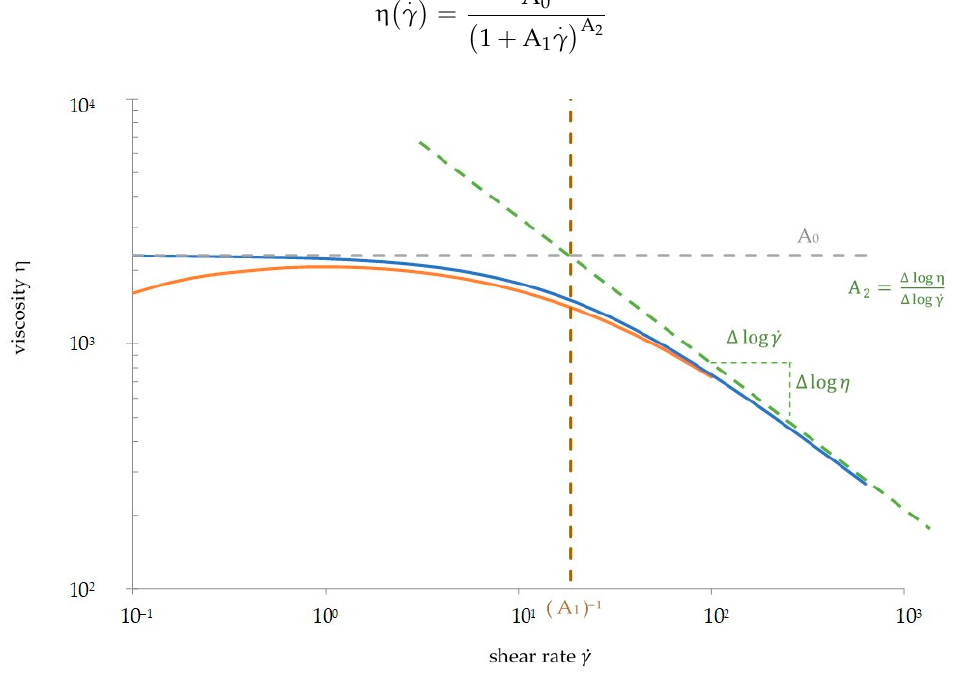
Figure 1. Viscosity curve of thermoplastics. The blue curve is an approximated viscosity curve derived from the Carreau model, and the orange curve is from the rheological measurement of PHBV.